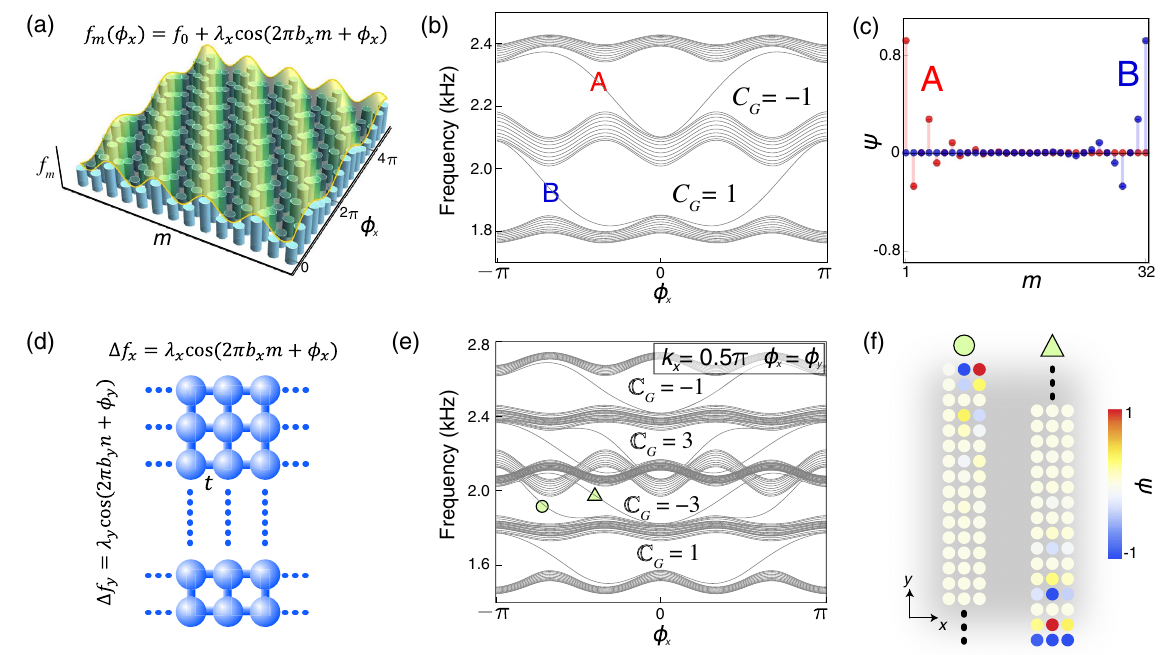
FIG. 1. 4D Chern insulator. (a) A schematic drawing of a 2D Chern insulator with one spatial and one synthetic dimension. The on-site frequency is modulated as f m ð ϕ x Þ , with ϕ x becoming the synthetic dimension. (b) The eigenfrequencies as functions of ϕ x calculated using the tight-binding model [Eqs. (1) and (2)]. Nonzero gap Chern numbers are marked in the band gaps. Two chiral boundary modes are shown in (c). A 4D Chern insulator can be attained using two spatial and two synthetic dimensions. Using a ribbon which is periodic in x but finite in y with N y ¼ 32 sites (d), we can compute the system ’ s eigenspectra. (e) shows the eigenspectra as a function of ϕ x sliced at k x ¼ 0 . 5 π and ϕ x ¼ ϕ y . The band gaps are associated with nonzero second Chern numbers as labeled. The bulk bands are closed by THMs localized at the x -direction edges. The real-space distributions of two THMs examples are shown in (f). All results here are obtained using a tight-binding